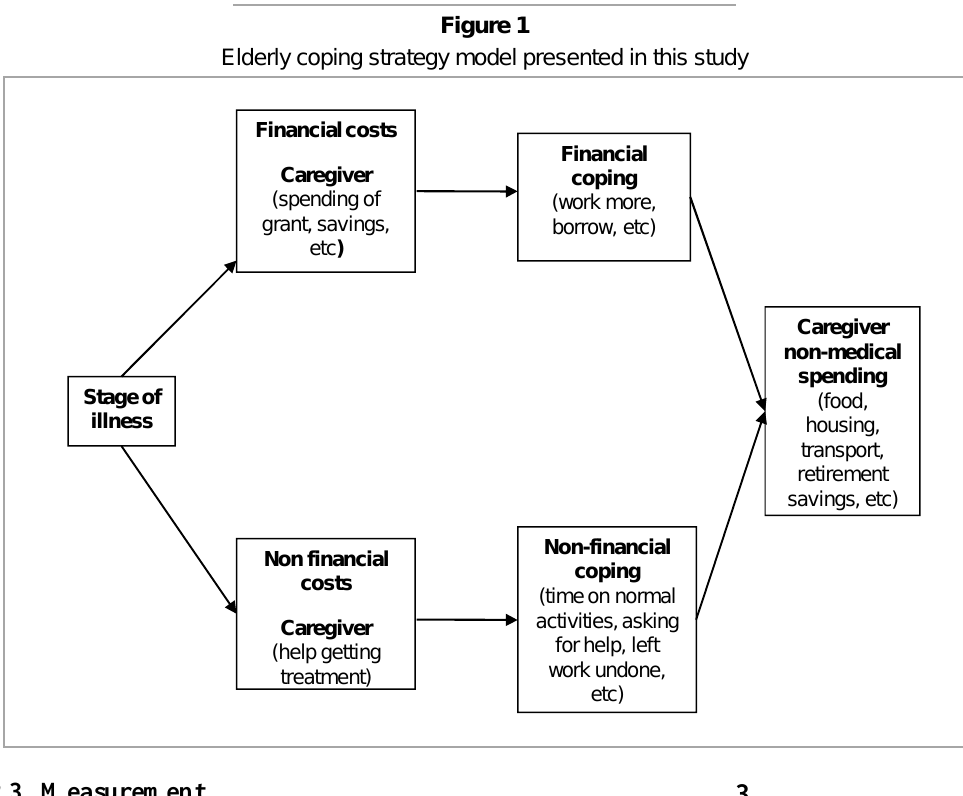
Financial coping (work more, borrow,